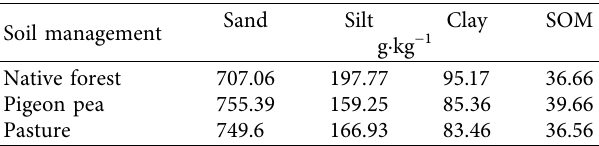
Figure 1: Location of study areas in the municipality of Novo Aripuanã, state of Amazonas, Brazil. Table 1: Soil particle distribution and organic matter of the Ar- chaeological Dark Earth at 0.0–0.20m depth layer with different soil managements at Novo Aripuanã,